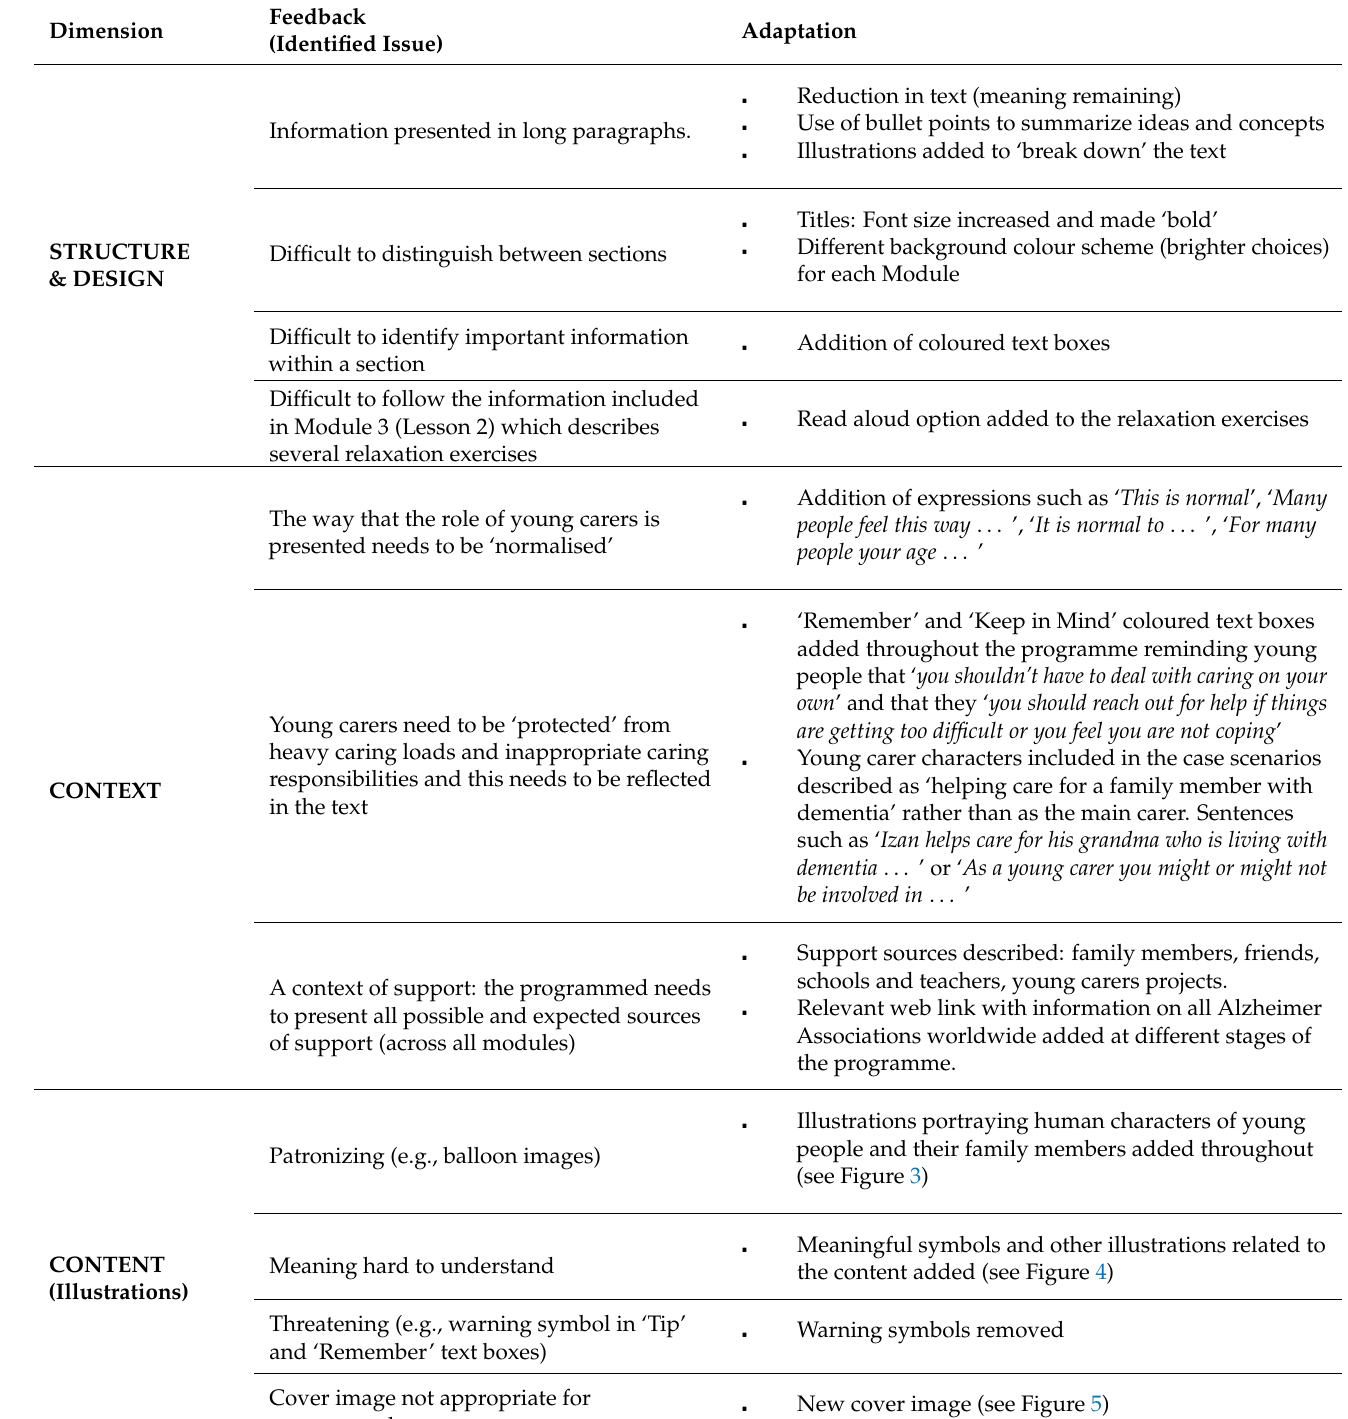
Table 3. Examples of feedback and adaptations according to the WHO adaptation guidelines and EVM